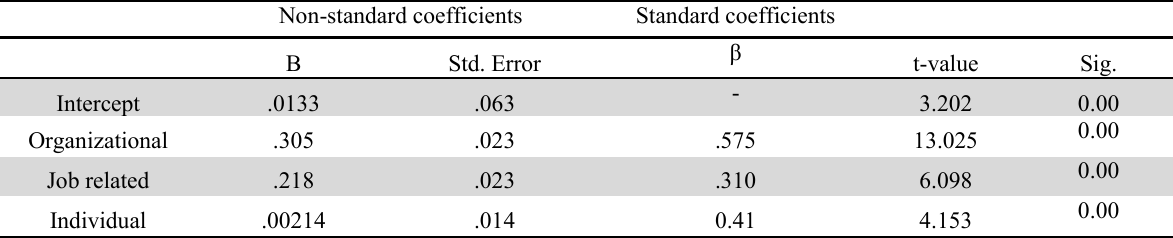
The results of regression analysis